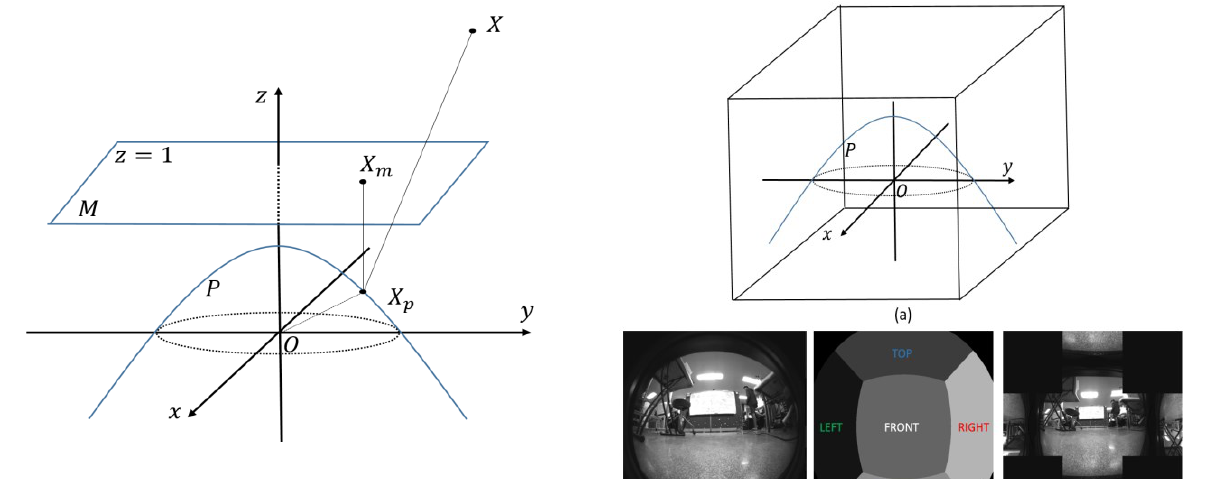
Figure 3 . Illustration of Enhanced Unified Camera Model.